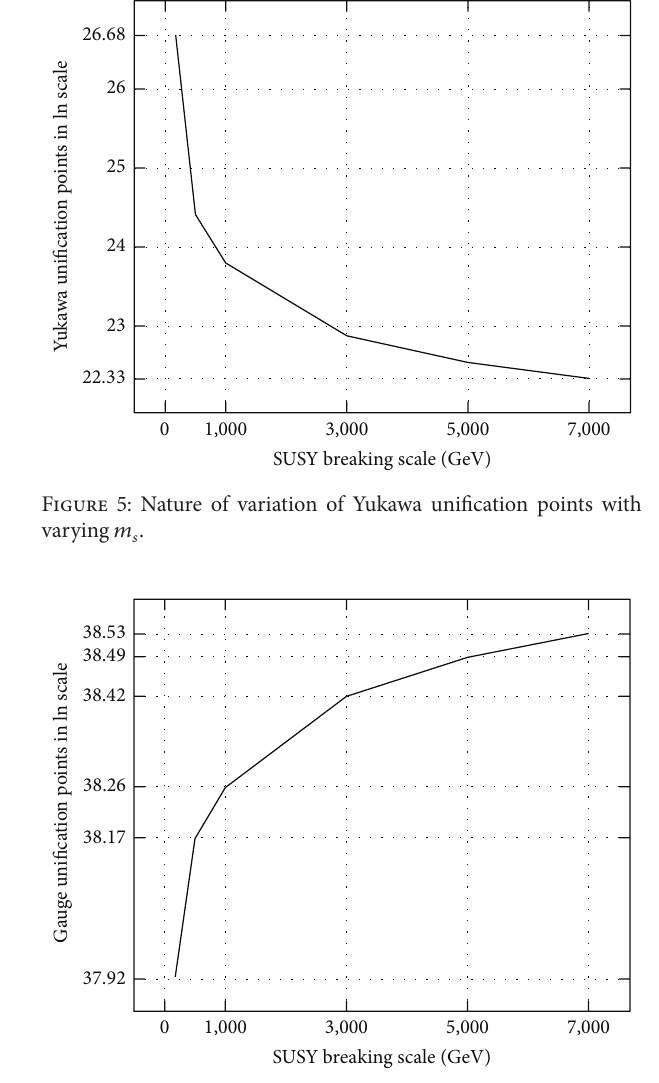
Figure 6: Nature of variation of gauge unification points with varying 𝑚 𝑠